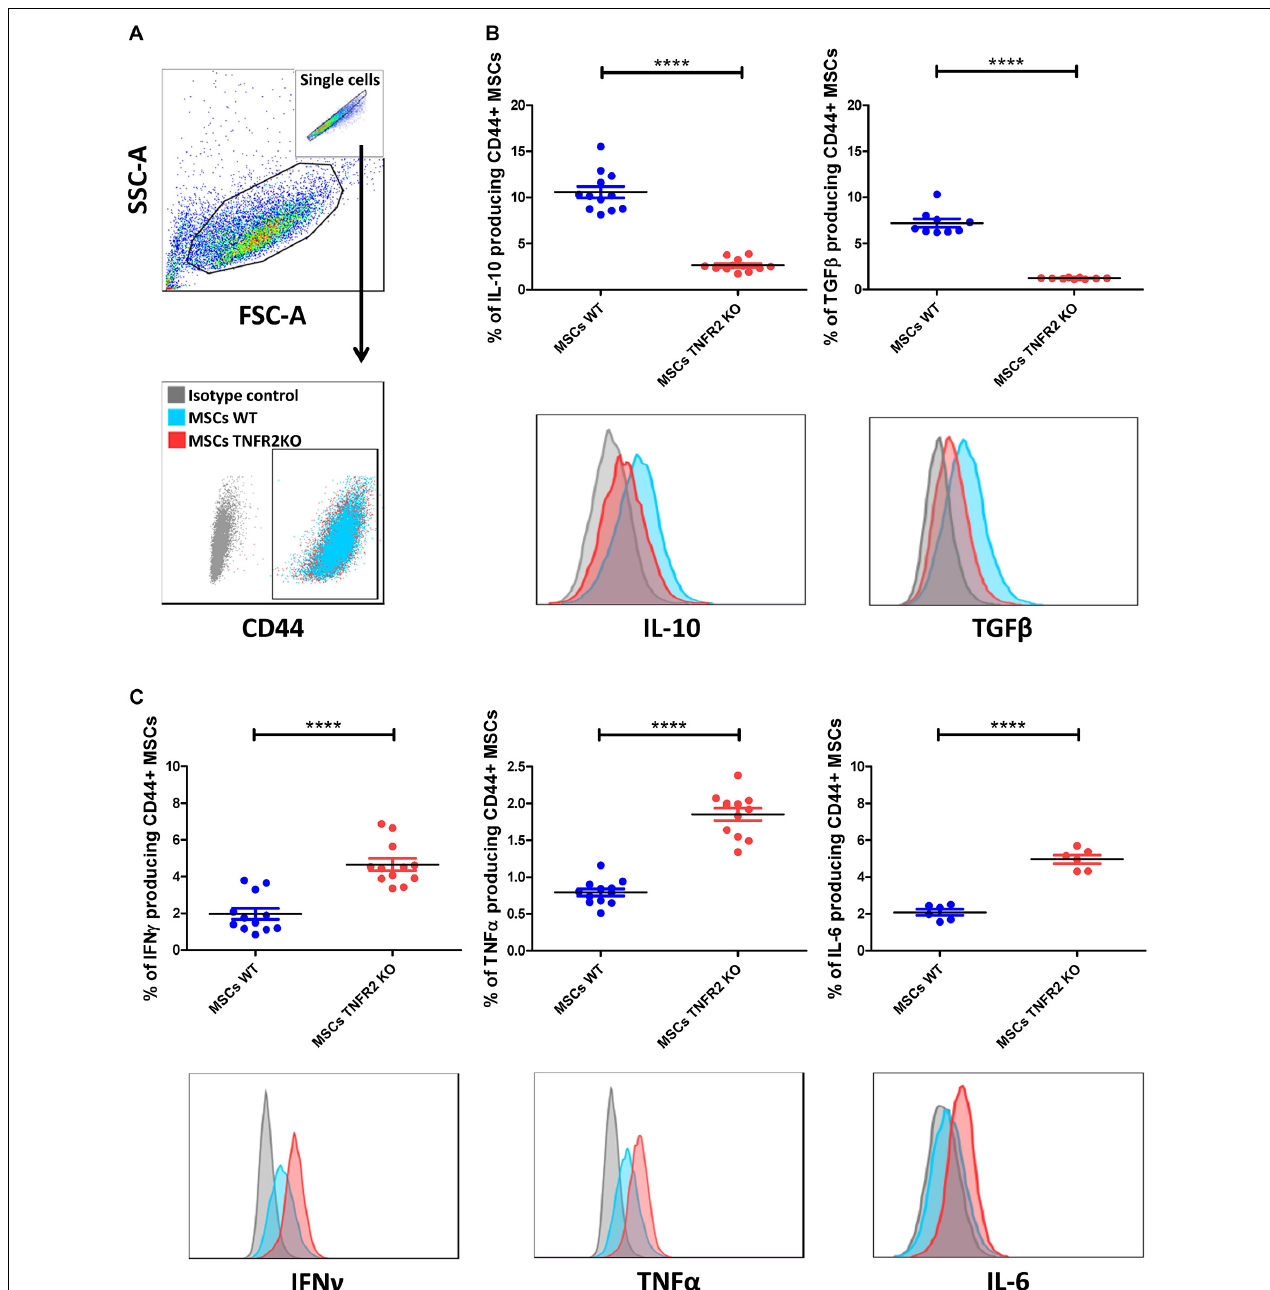
FIGURE 3 | The TNFR2 expression modulates mesenchymal stem cell (MSC) capacity to produce anti-inflammatory and pro-inflammatory cytokines. Wild-type (WT) and TNFR2 knockout (KO)-MSCs were first activated by the addition of 10 ng/ml of TNF α . After 48 h, they were analyzed for their capacity to produce different anti-inflammatory and pro-inflammatory cytokines. (A) These flow cytometric representatives depict the initial gating strategy. Single cells were initially selected in SSC-A and FSC-A panels. Then, CD44 + MSCs were selected for further analysis. (B) Intracellular anti-inflammatory cytokine and (C) pro-inflammatory cytokine production was determined in WT and TNFR2 KO-MSCs. Gray histograms depict isotype controls, red histograms depict TNFR2 KO-MSCs, and blue histograms depict WT-MSCs. Each measured value is presented by a dot, and horizontal lines depict mean value ± SEM. Data are representative of three independent experiments. n = 12 for all cytokines except for IL-6 ( n = 6) and TGF β ( n =